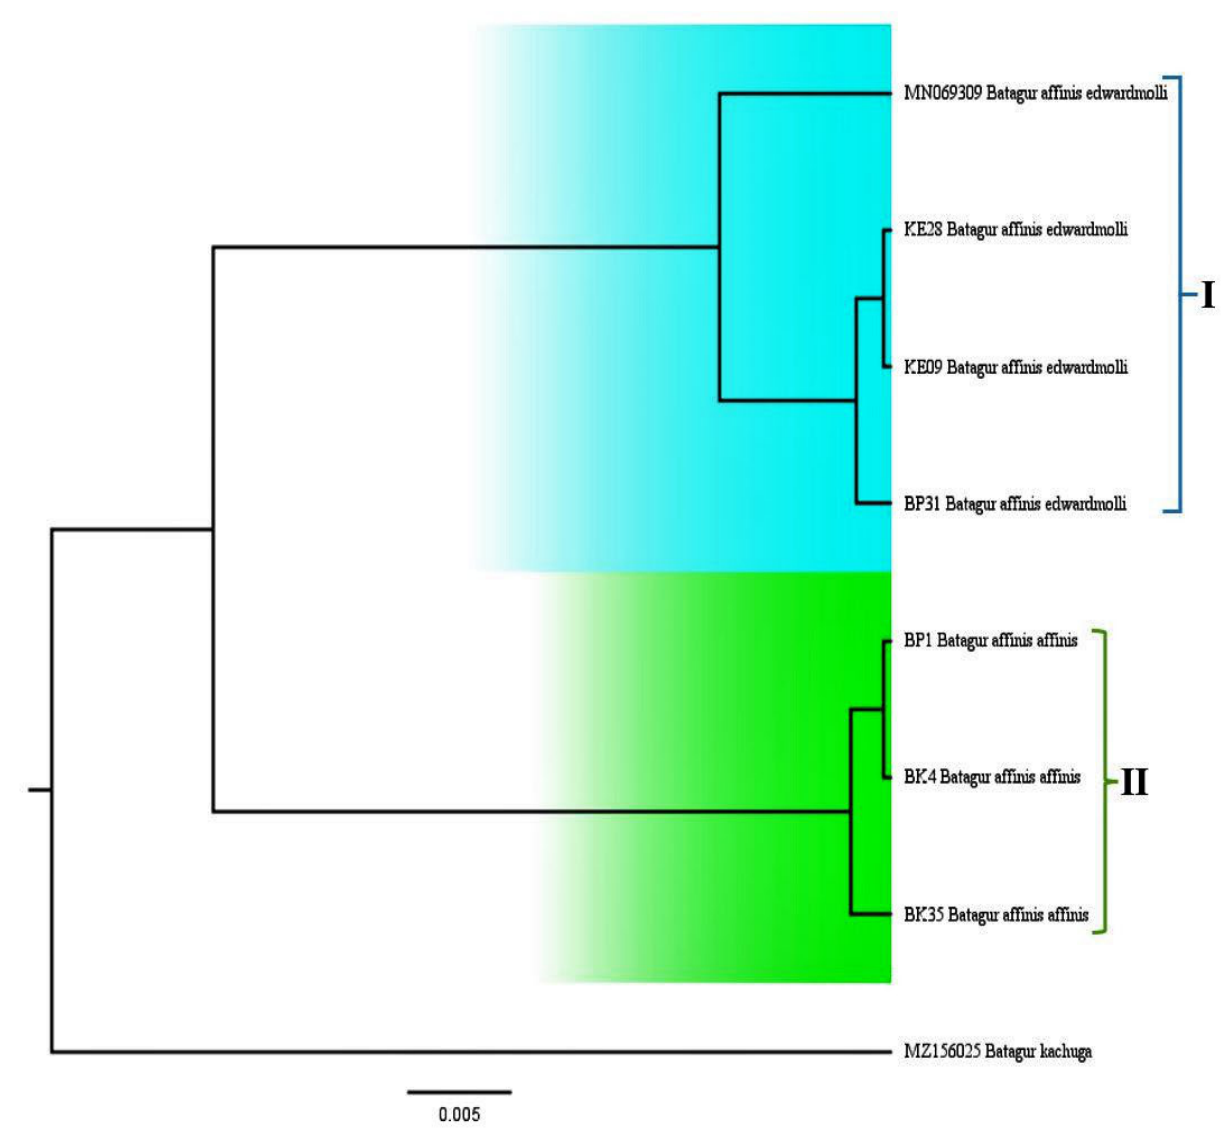
Figure 4. Phylogenetic tree showing the relationship, generic, and species positions based on Bayesian analysis of the mtDNA D-loop (652 bp) of Batagur affinis . The phylogenetic tree also shows the relationship between B. a. edwardmolli’s D-loop haplotypes and Batagur kachuga as the outgroup. The map (Figure 2) shows sampling locations and corresponding mtDNA haplotype frequencies (absolute and relative frequencies are indicated by the numbers in parentheses and coloured fractions of the pie graphs, respectively) of Batagur affinis populations from Peninsular Malaysia. The examination was based on haplotypes of the mtDNA D-loop (ca. 652 bp) from a total of 120 individuals. HAP_2 was shown be found in the greatest number of localities compared to HAP_1, HAP_4, and HAP_6. The B. a. affinis from BK, Perak, and BP, Kedah, were both found to have the greatest variety of